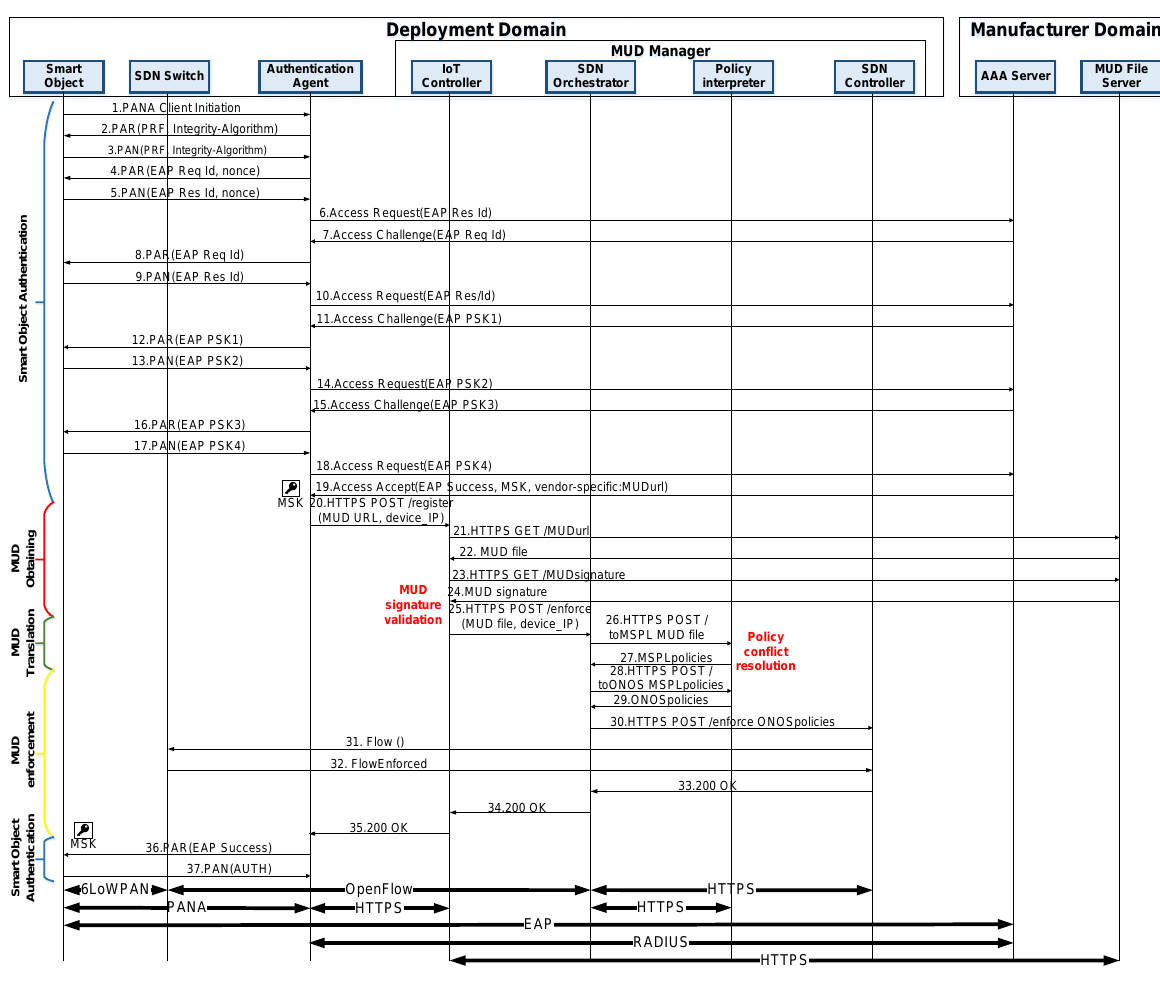
Figure 3. Flow diagram of the